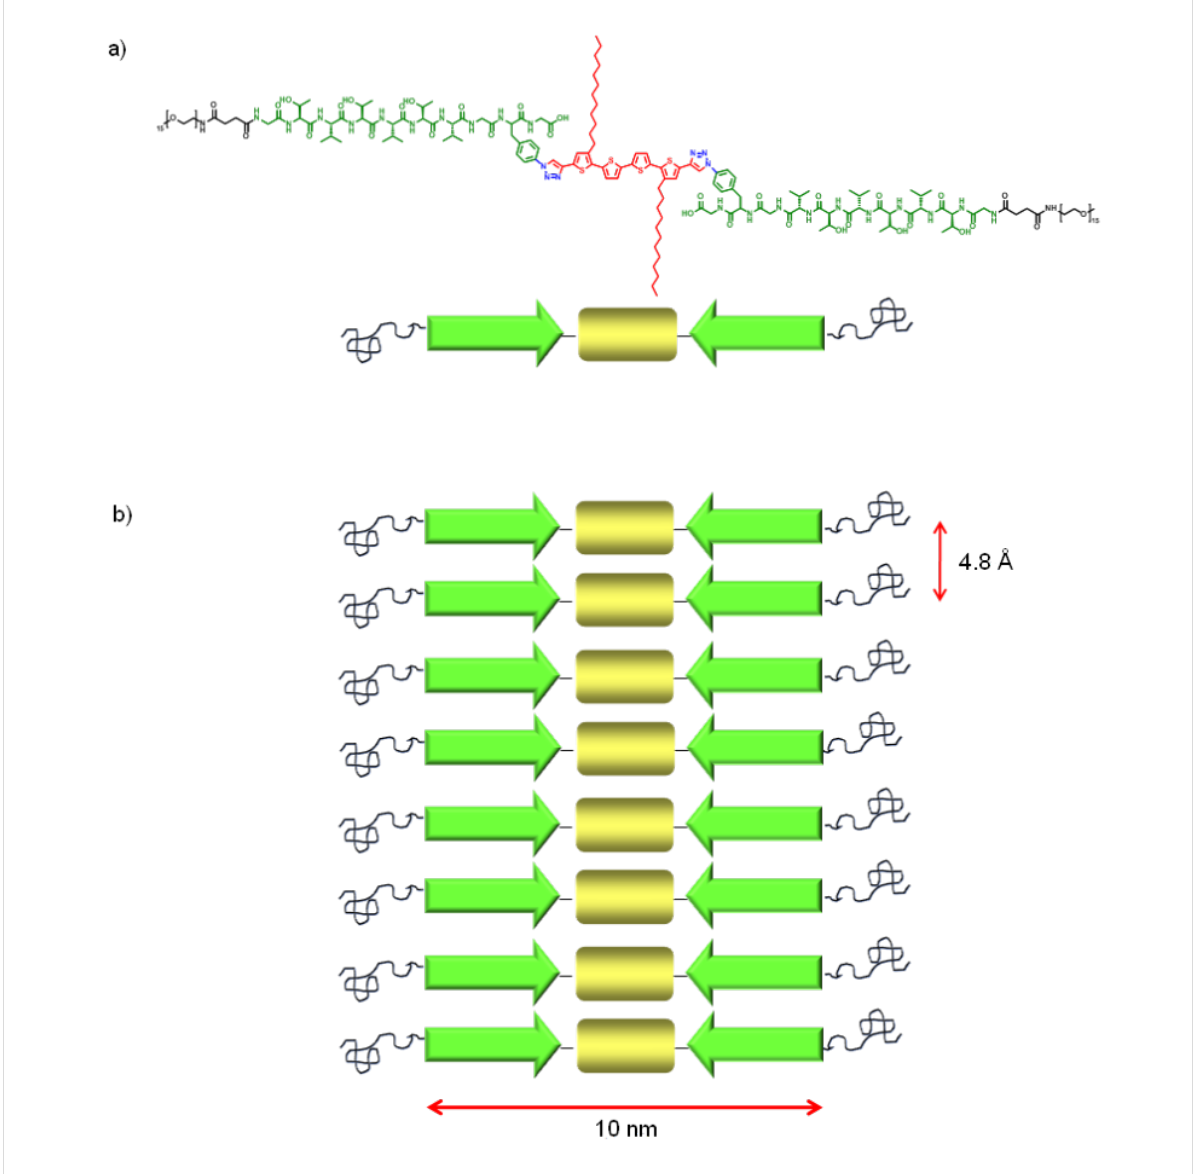
Figure 9: a) Schematic representation of hybrid 1 . Black coils: PEO chains, green arrow: Peptide strand; yellow box: Quaterthiophene; b) Model of parallel β -sheet superstructures of hybrid 1 .